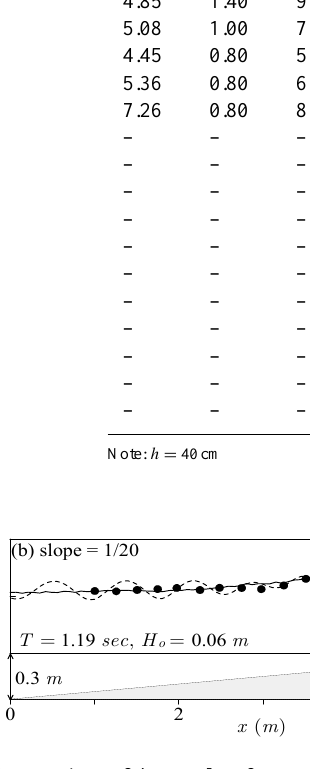
Figure 2. Comparison of the results of wave height distribution along a uniform slope of 1:20 among the present numerical model (-), numerical computation using MSE (---, Hsu et al. 2005), and the labo- ratory experiments ( • ) of Nagayama (1983). Input wave conditions: T = 1 . 19s, H 0 = 0.06m, and h = 0 . 3m at the